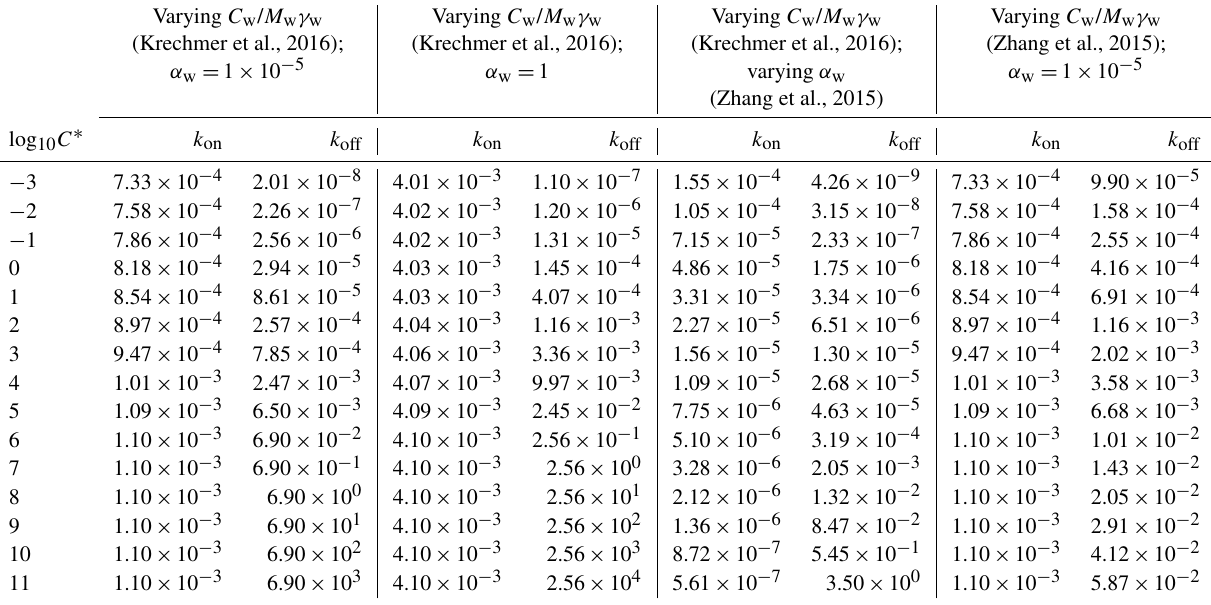
Table 4. Vapor-wall-loss rate constants (s − 1 , k w , on , and k w , off ) for each volatility bin for cases with varying C w / M w γ w (Krechmer et al., 2016), for different XX α w as shown; last column is for the case varying C w / M w γ w as in Zhang et al. (2015). Varying C w / M w γ w Varying C w / M w γ w Varying C w / M w γ w Varying C w / M w γ w (Krechmer et al., 2016); (Krechmer et al., 2016); (Krechmer et al., 2016); (Zhang et al., 2015);